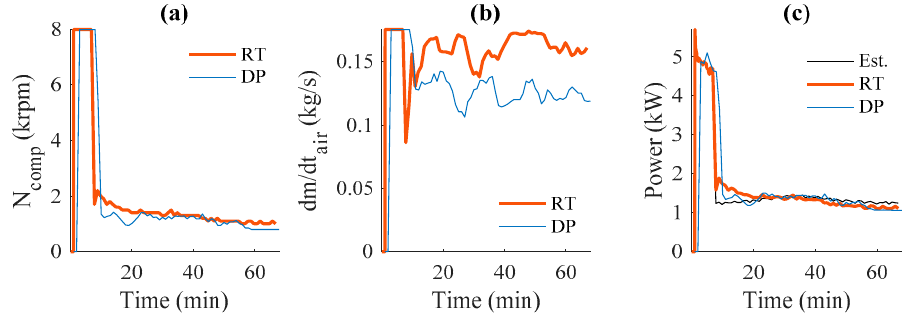
Figure 15. HVAC system results for SOC ini = 28.0%: ( a , b ): compressor speed and air flow trajectories